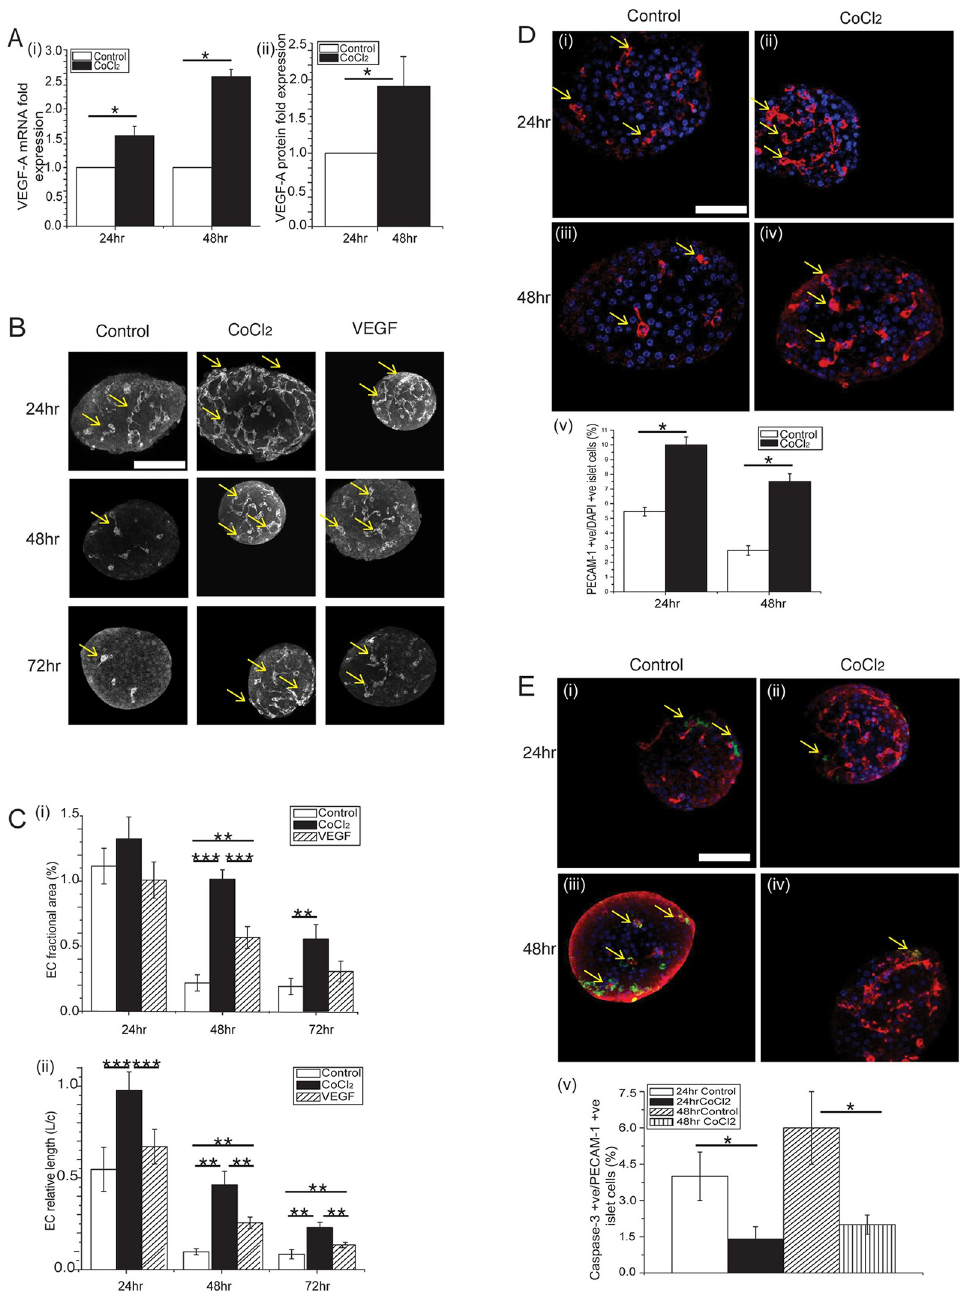
Fig 3. Effect of CoCl 2 on islet VEGF expression and EC-morphology and -number. (A)(i) RNA was extracted from islets cultured in varying CoCl 2 for up to 48hrs. Bar graph represents VEGF-A mRNA levels in control (0 μ M CoCl 2 ) islets (white bars) compared to 100 μ M CoCl 2 treated islets (black bars) (n = 5 mice on separate days). (A)(ii) Bar graph shows VEGF-A protein expression of islets cultured over 48hrs (n = 10 mice on separate days). Error bars are ± SEM; � p < 0.05. Statistical significance was determined by two-tail student’s t-test. (B) Image panel of control (0 μ M CoCl 2 ); 100 μ M CoCl 2 and 100 ng/ml VEGF-A treated islets cultured for up to 72hrs, fixed and immunoflourescently labeled with Alexa Fluor 633 for PECAM-1 (shown in gray); yellow arrows point to PECAM-1 positive cells (scale bar = 50 μ m). (C)(i) Bar graph showing the EC fractional areas of differently treated islets cultured over 24hrs, 48hrs and 72hrs. (n = 15 mice on separate days). (C)(ii) Bar graph shows the EC relative length of islets cultured over 24hrs, 48hrs and 72hrs (n = 15 mice on separate days). Error bars are ± SEM; �� , p < 0.01; ��� , p < 0.001. Statistical significance was determined by one-way ANOVA with post-hoc Bonferroni test. (D)(i-iv) Image panel of control (0 μ M CoCl 2 ) and 100 μ M CoCl 2 treated